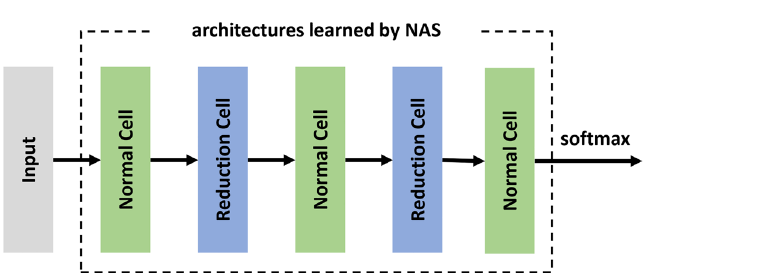
Figure 3. CNN structure with five cells for bearing fault diagnosis.